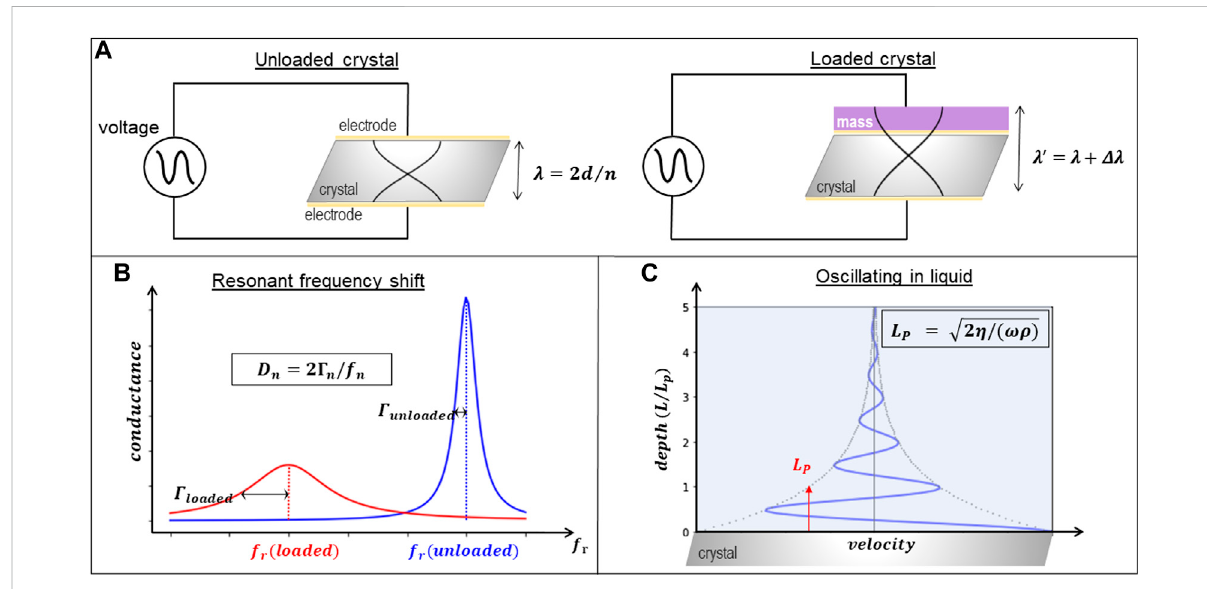
FIGURE 2 Description of QCM operation principle. (A) Oscillation of the quartz crystal (of thickness d) driven by the electrodes without (left) and with (right)materialdepositedontop illustrating howthewavelength λ oftheresonancefrequencychanges to λ ’ for differentovertonesn. (B) Illustration of the energy dissipation (D n ) extracted from the bandwith ( Γ n ) and frequency (f n ) changes of the loaded crystal. (C) Illustration of the penetration length (L